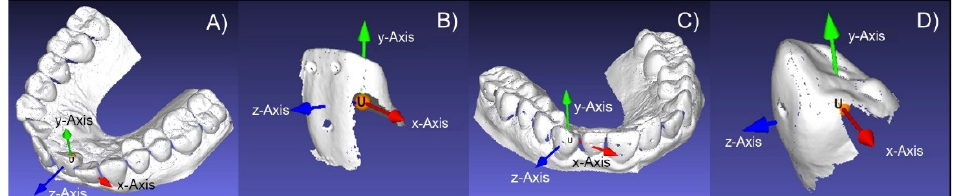
Figure 1. Orientation of the coordinate systems relative to the crown: tooth 11 in the dental arch ( A ) and the separated tooth ( B ); tooth 23 in the dental arch ( C ) and the separated tooth ( D ).